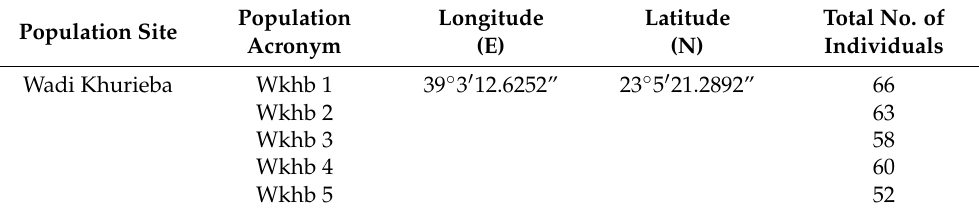
Table 1. Sites and population information: acronyms used to refer for populations, coordinates of sites, and population size of the twenty known populations of R. epapposum in a region of western Saudi